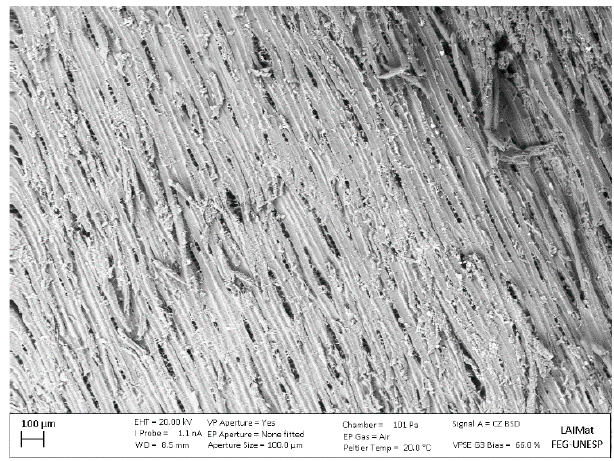
Figure 5. SEM image of veneer surface treated at 180 °C.